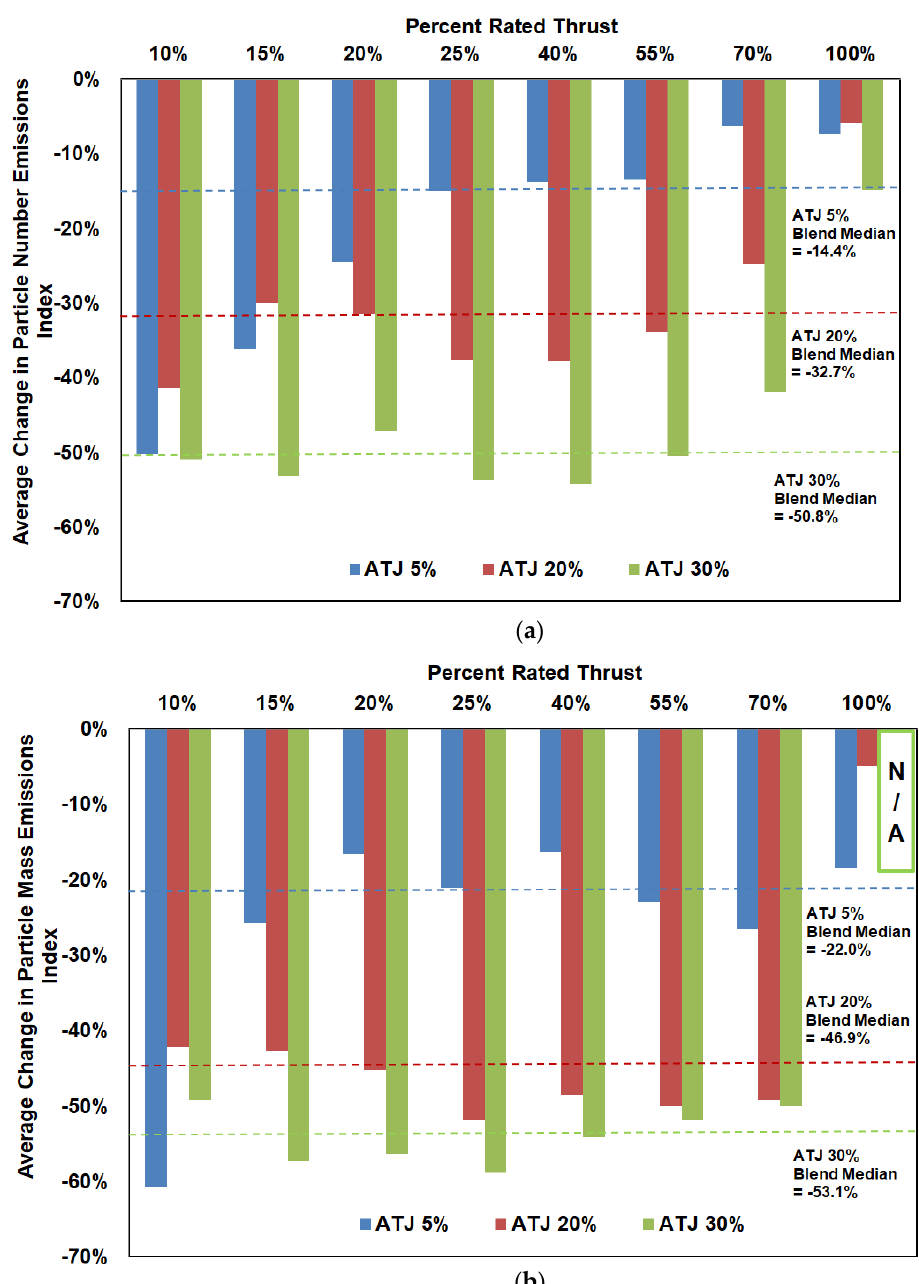
Figure 6. Average change in emissions index relative to Jet A-1 at different engine thrust for ( a ) particle number and ( b ) particle mass emissions. Also shown are the median values for each data set.